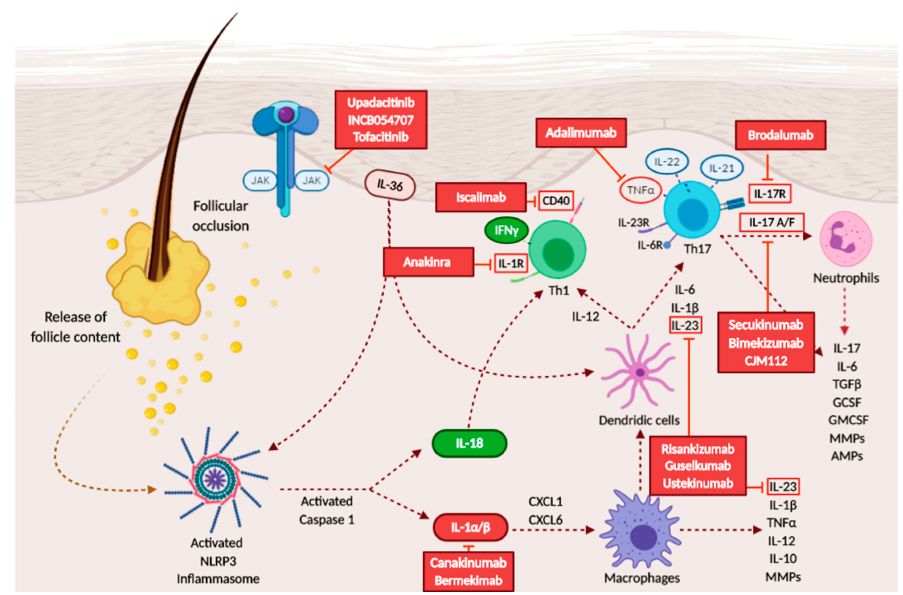
Figure 3. Schematic representation of the therapeutics targeting the immune products involved in HS pathogenesis.